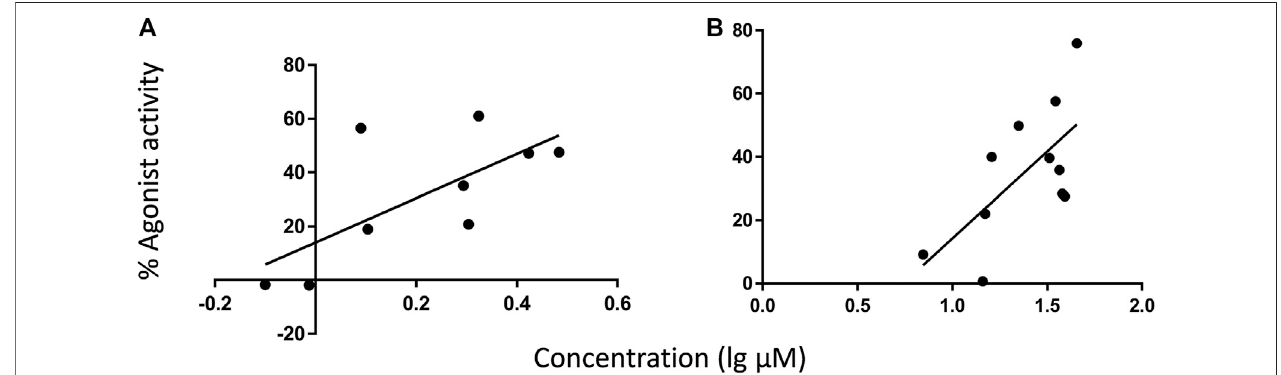
FIGURE 4 | Regressions of CB receptor internalization (% agonist activity) relative to AKA9 + 10 concentration in different root extracts under experimental conditions.AKA9+10concentrationswerepositivelyrelatedtoagonistactivityatCB1among E.purpurea accessions (A) ,andatCB2among E.angustifolia accessions (B) .AKAconcentrationslistedin Table1 wereadjustedtoin-wellconcentrationthenconvertedfromµg/mltoµm(MWofAKA9/10 (cid:1) 247.38 g/mol).Referto Table2 for linear regression results.